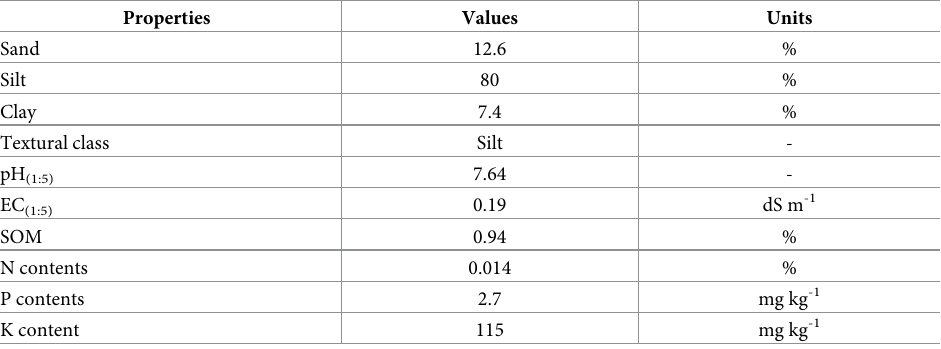
Table 1. Physico-chemical characteristics of experimental soil. Properties